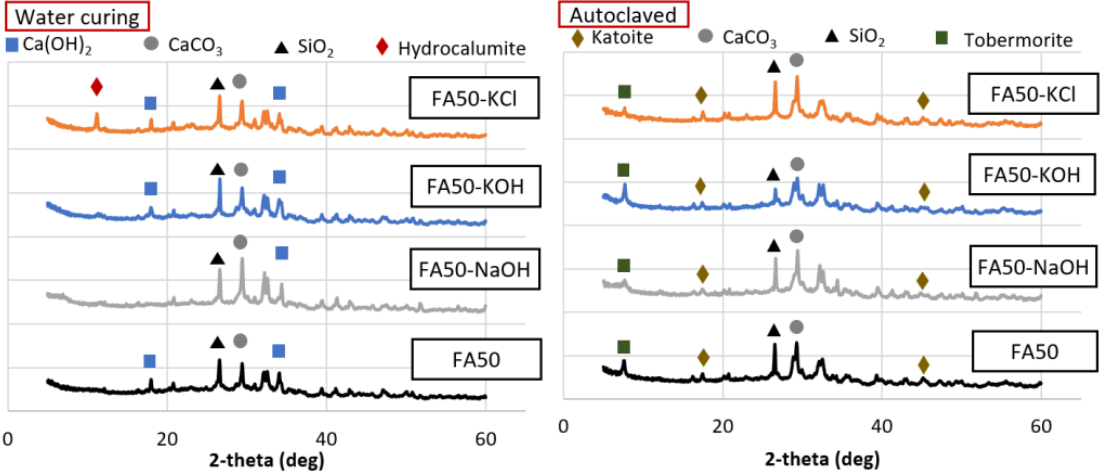
Figure 8. Mineral analysis of the 50% FA and 50% OPC mortar samples with KCl separated from CBD, NaOH, and KOH as activators.